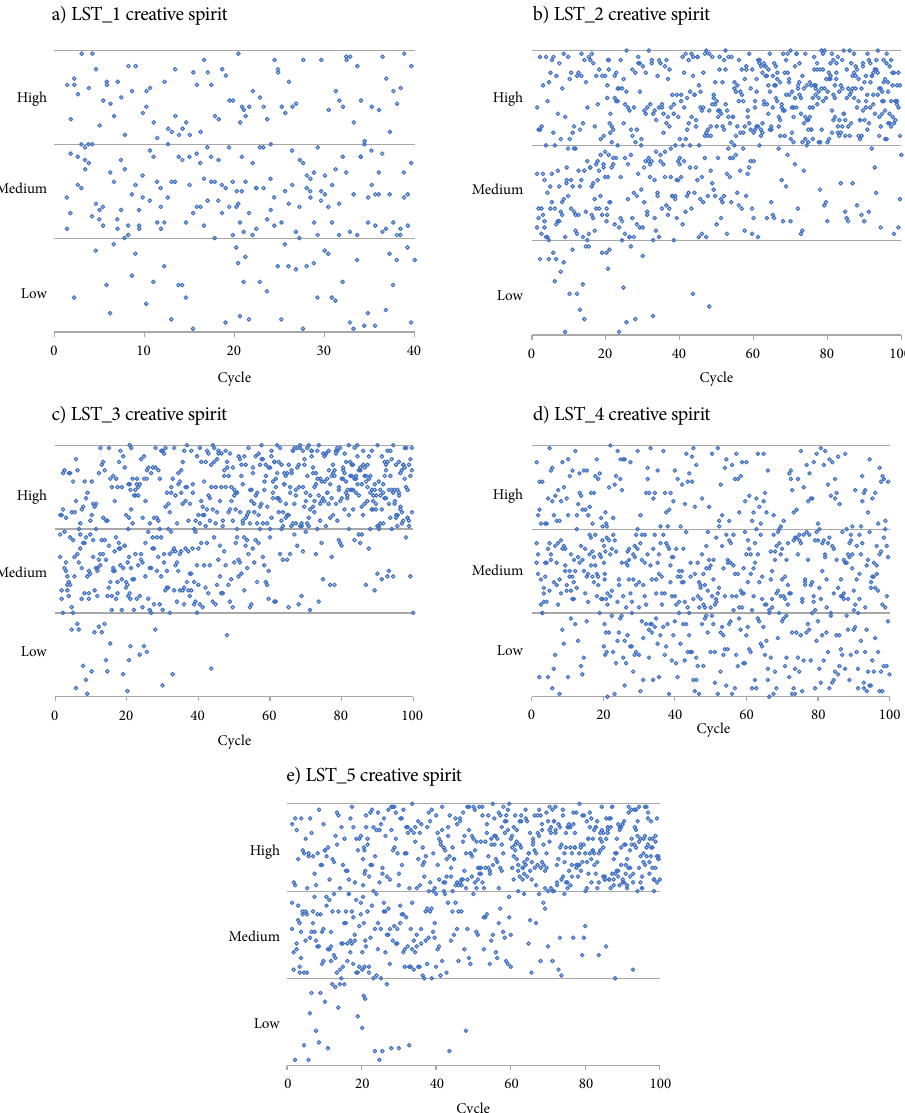
Figure 9. Evolution of entrepreneurs’ innovative spirit in different policy scenarios of low-structured social